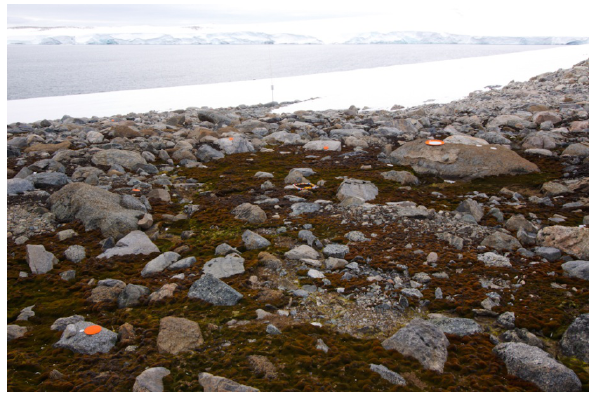
Figure 2: Moss bed area at the Robinson Ridge site with a vari- ety of healthy moss (green), stressed moss (red/brown), and dead moss (black). Small orange discs (10 cm diameter) and trays ( 30 cm diameter) used as GCPs for geometric correction and valida- tion are visible in the